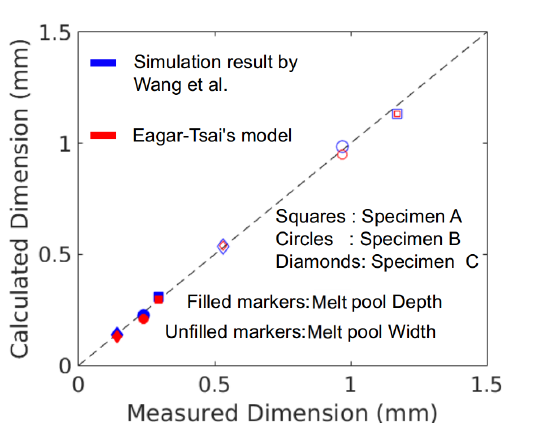
Figure 3. Comparison of experimentally measured melt pool dimensions with simulations results provided by Wang et al. (blue markers) [36] and the present work (red markers). Squares correspond to Specimen A, circles to Specimen B, and Diamonds to Specimen C. The filled markers indicate the melt pool depths and the unfilled ones indicate the melt pool width.